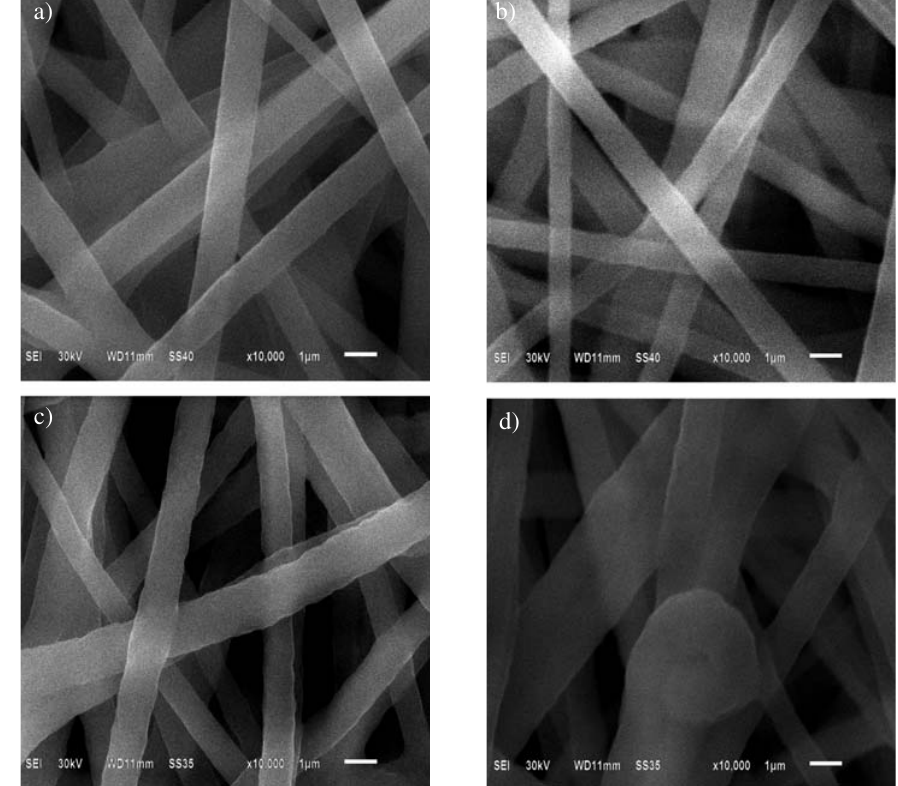
Fig. 1. SEM images of TPU/PVDF/PS electrospun membranes (a) 9 wt.% (b) 10 wt.% (c) 11 wt.% (d) 12